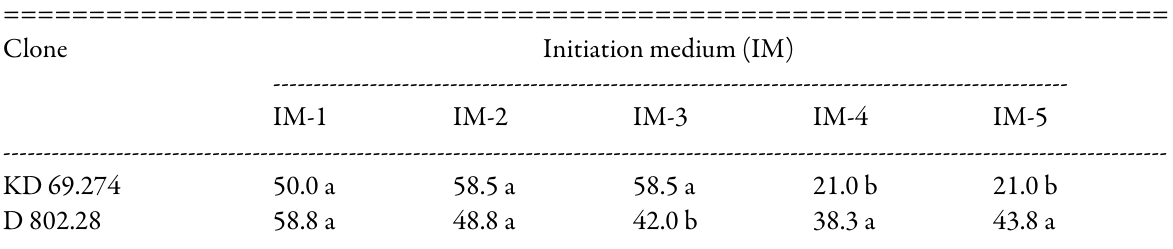
Table 1. Interaction effect of clones and media on percentage of explant regeneration (%)